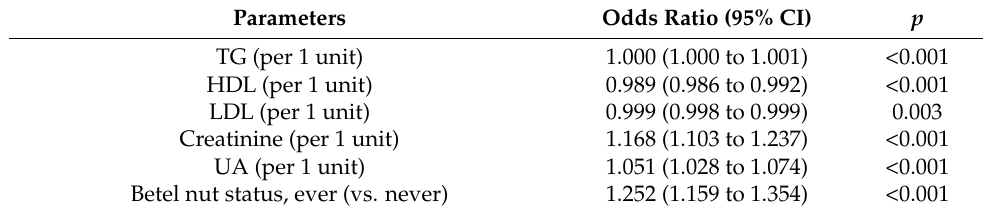
Abbreviations: as Table 1 and CI: confidence interval.